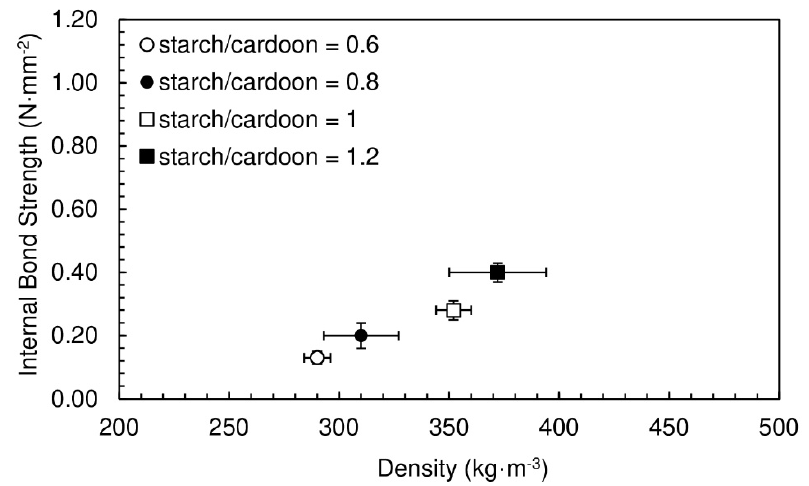
Figure 2. Internal bond strength of particleboards bonded with potato starch as function of density for starch/cardoon ratios of 0.6, 0.8, 1 and 1.2. All formulations had a water/starch ratio of 2.